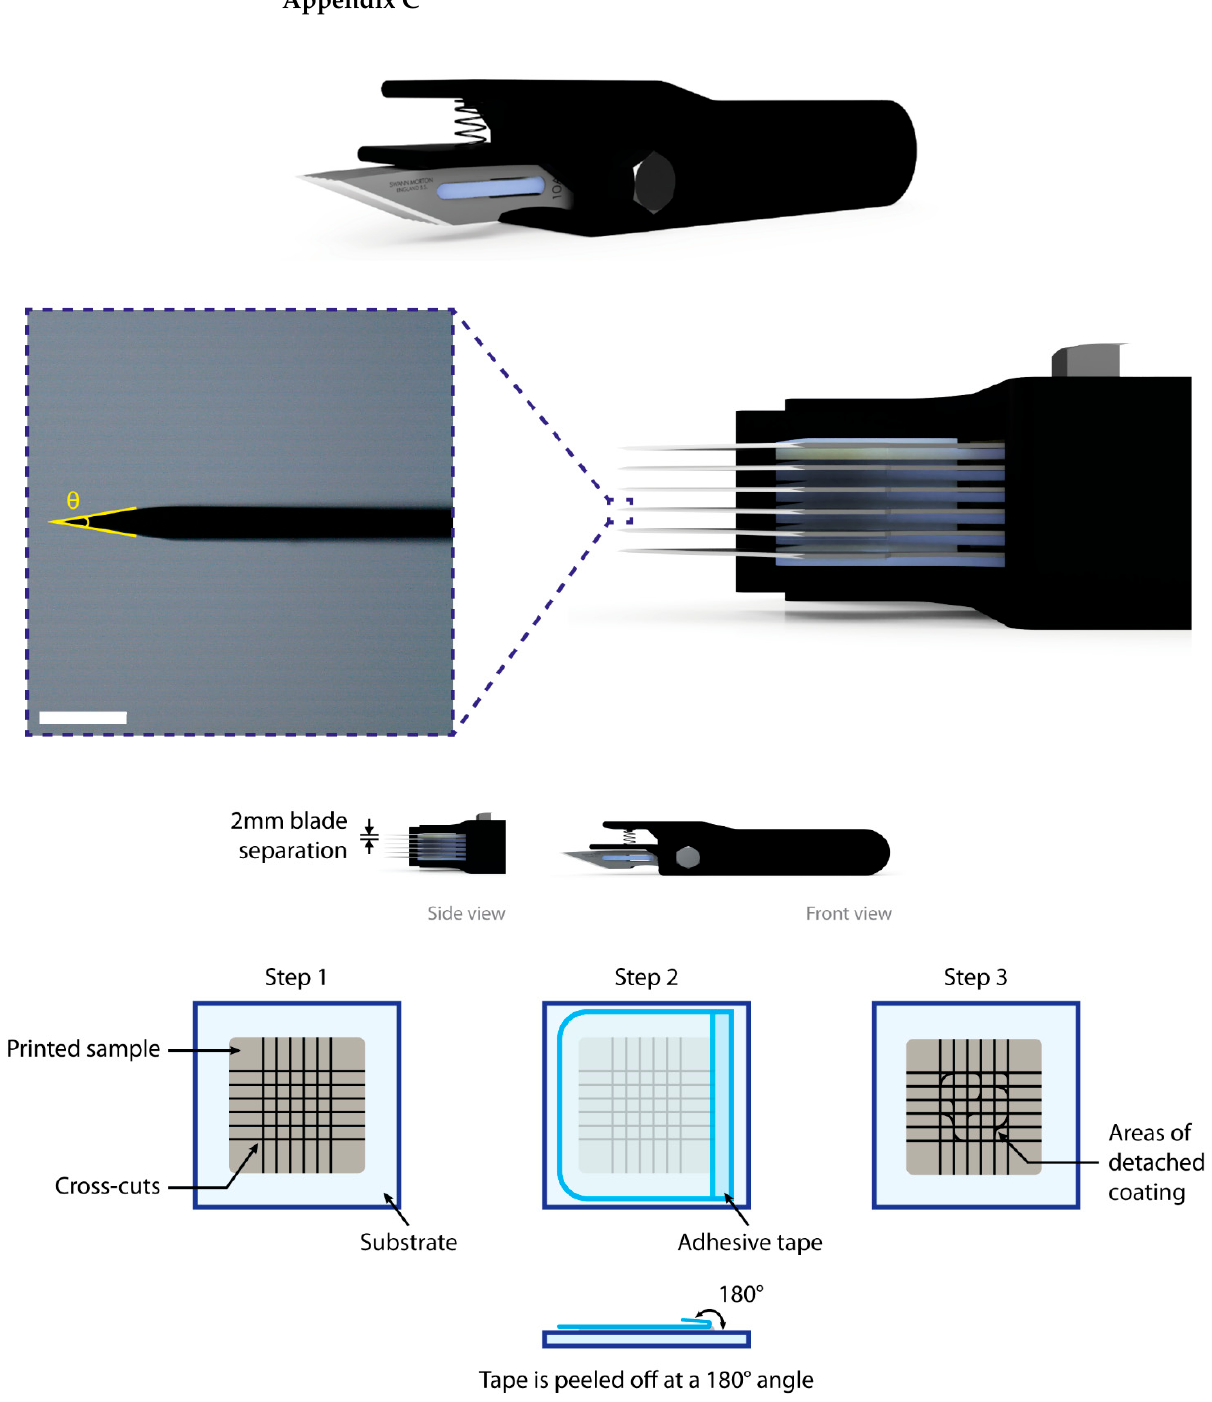
Figure A3. Illustration of the cross-cut procedure, showing an in-house fabricated cutter used to maintain a 2 mm separation between the blades, and the 3-step process of evaluating the adhesion of the printed sample.